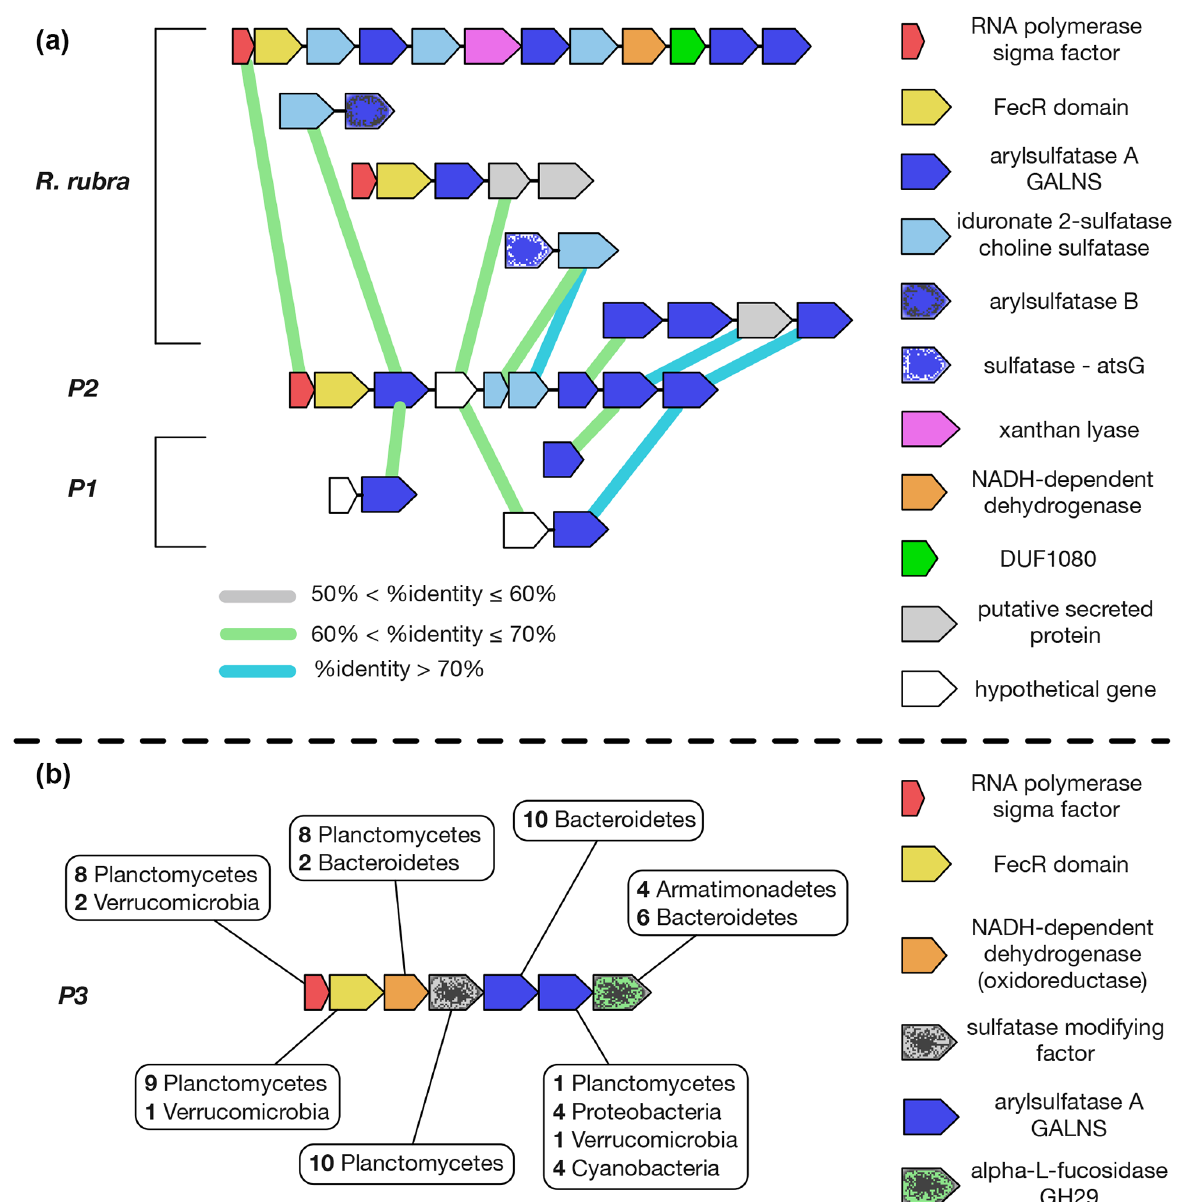
Fig 4. Changing context of sulfatase genes in operons. (a) Changing genetic context of individual sulfatase genes of a co-oriented P2 sulfatase gene cluster, resembling an operon. Adjacent genes are joined by a black line, and all genes are color-coded by predicted function as given on the right-hand side of the figure. P1 and R . rubra homologs for individual sulfatase genes in the P2 operon are shown. For each homolog, the immediate context of adjacent, co- oriented genes within their respective genomes is also shown. Reciprocal best-hit genes across organisms are connected by thick colored lines (gray, green, cyan). ORF lengths and intergenic distances are not drawn to scale. (b) A heterophyletic gene cluster resembling an operon in P3. Seven consecutive genes are color-coded by predicted function as given on the right-hand side of the figure. The distribution of top 10 BLASTp hits across various bacterial phyla is provided for each